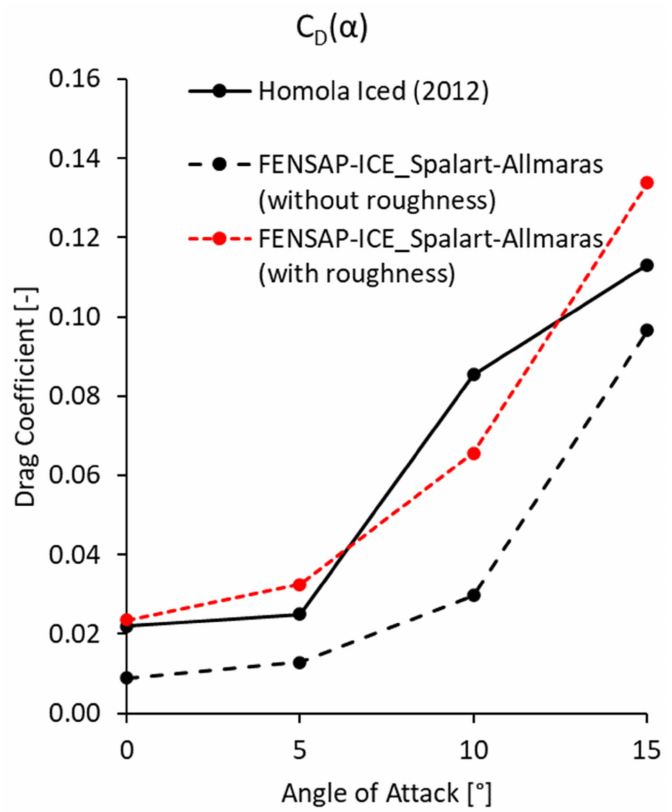
Figure 10. Drag coefficient for the iced airfoil estimated with and without roughness in comparison with